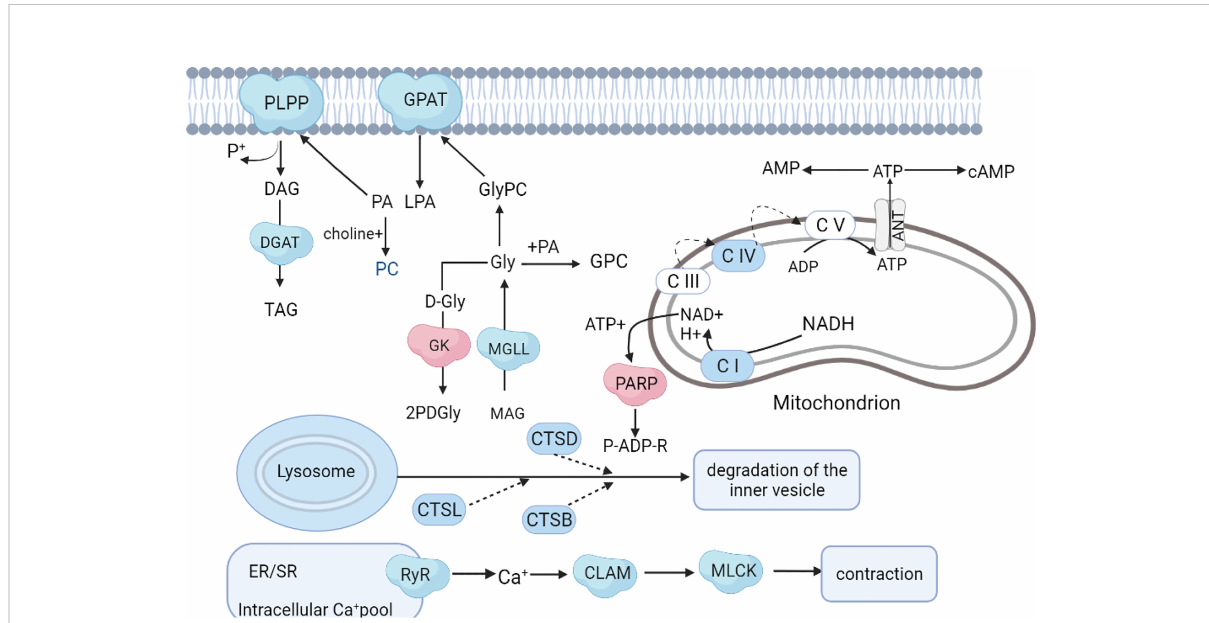
FIGURE 8 Hypothetical network of proteins, metabolites, and pathways in A. japonicus affected by SMC treatment. The colors red and blue represent up- and down-regulation,